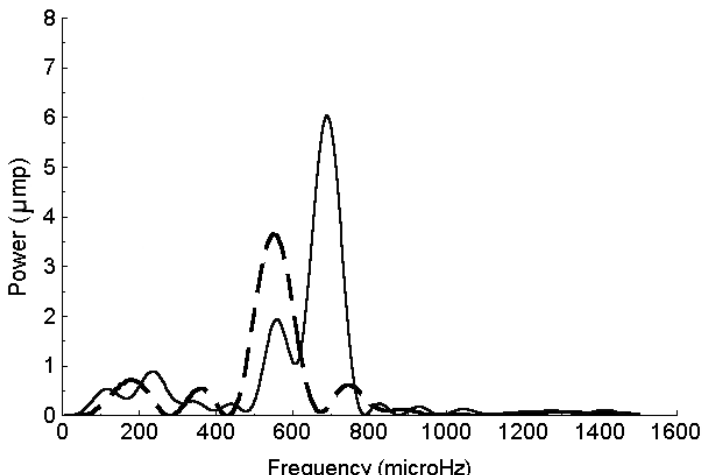
Fig. 2. Comparison of NGC 246 temporal spectra from the NOT data. The dashed line is the temporal spectrum of the July 21 run and the continuous line – the temporal spectrum of the July 24